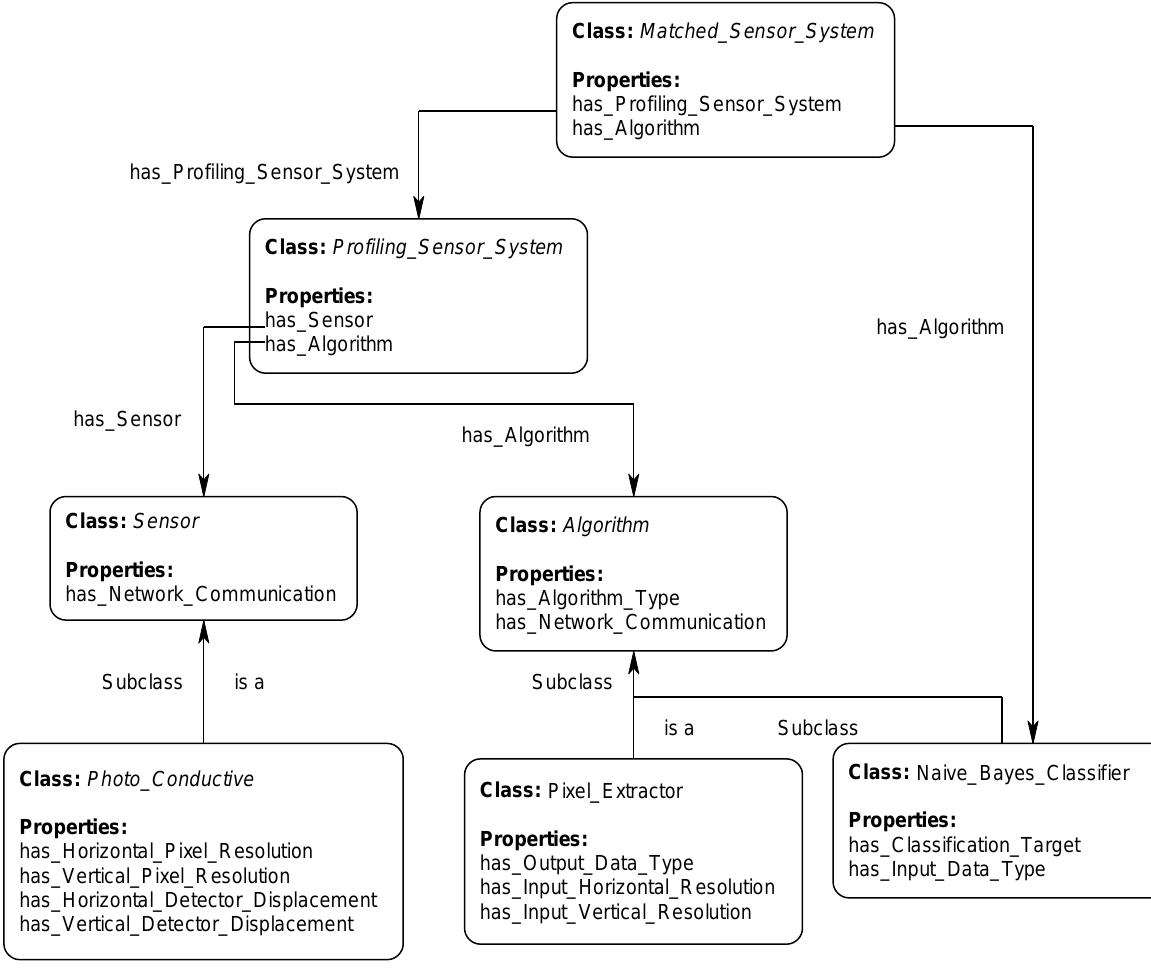
Figure 12. Excerpt of the properties for representative classes and subclasses for the reasoning process in the ontological problem-solving